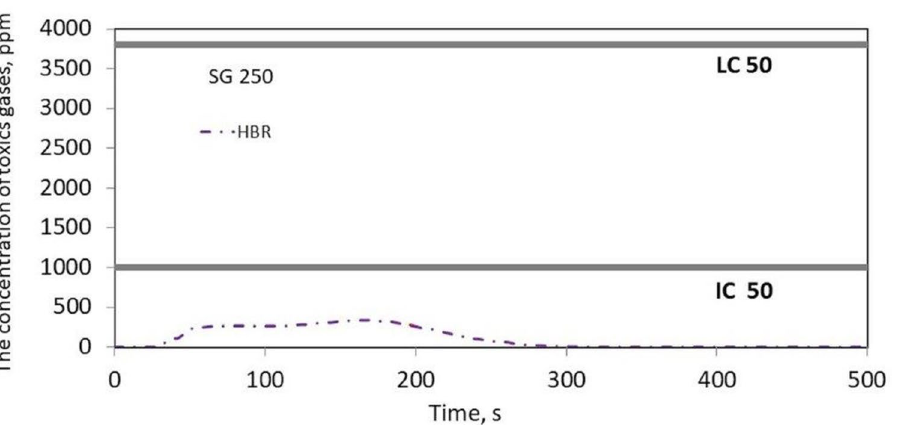
Figure 7. HBR concentration as a function of time during thermal decomposition and combustion of the tested belt samples with the indication of permissible values (Table 2).